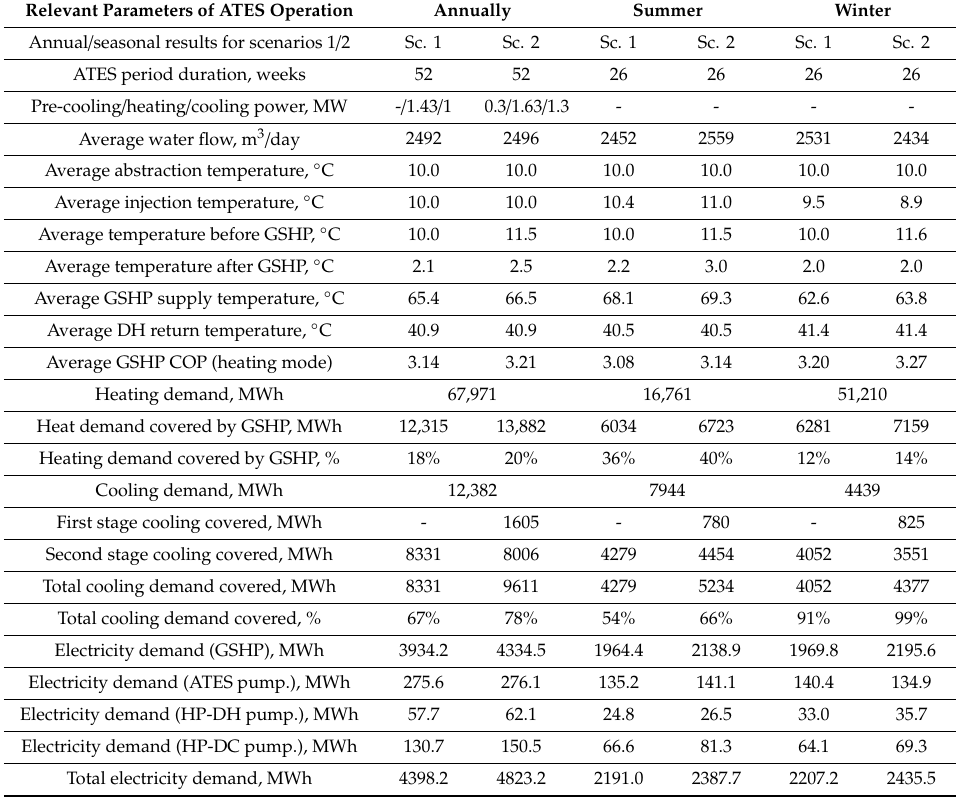
Table 4. ATES system technical